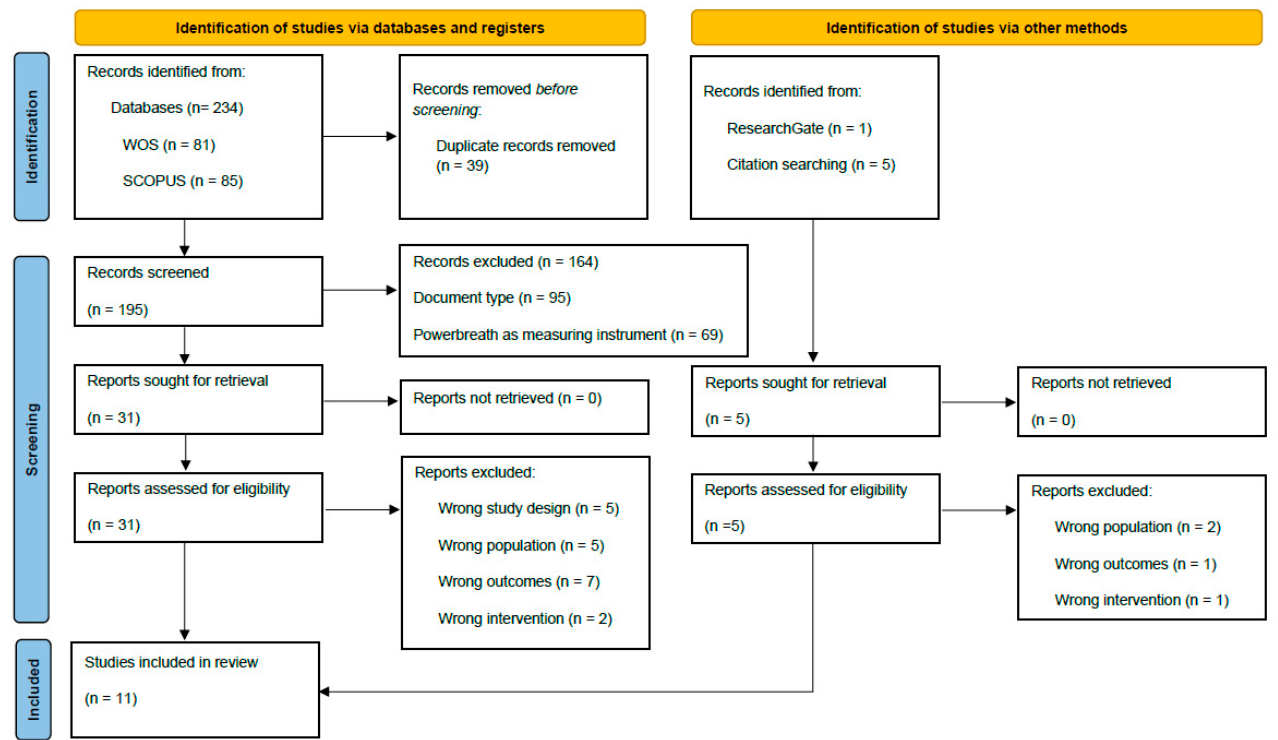
Figure 1. Flow diagram depicting the identification and selection processes of relevant studies ac- cording to Preferred Reporting Items for Systematic Reviews and Meta-Analyses (PRISMA) guide-